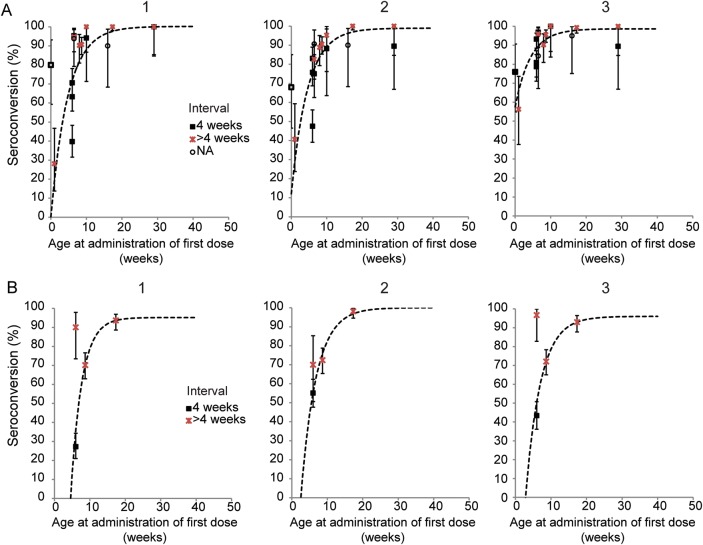
Proportion of children seroconverting to each serotype after 2 doses of inactivated poliovirus vaccine (IPV), plotted against age at administration of the first dose. A, Full-potency IPV given intramuscularly. B, Fractional (1/5) dose IPV given intradermally using a needle and syringe or needle-free device. The legend indicates the interval between the doses, and the error bars the 95% confidence intervals. The dashed line indicates the trend in seroconversion with age at administration of the first dose based on an exponential curve with intercept and asymptote estimated from the data using maximum likelihood. The asymptote was constrained to be ≤100%. Seroconversion is defined as in Figure 1 (see Supplementary Table 2 for details for each study). Data from the study in India with significant seroconversion to serotypes 1 and 2 in the control arm are shown in gray as for Figure 1 and excluded from the maximum likelihood curve fit [8].